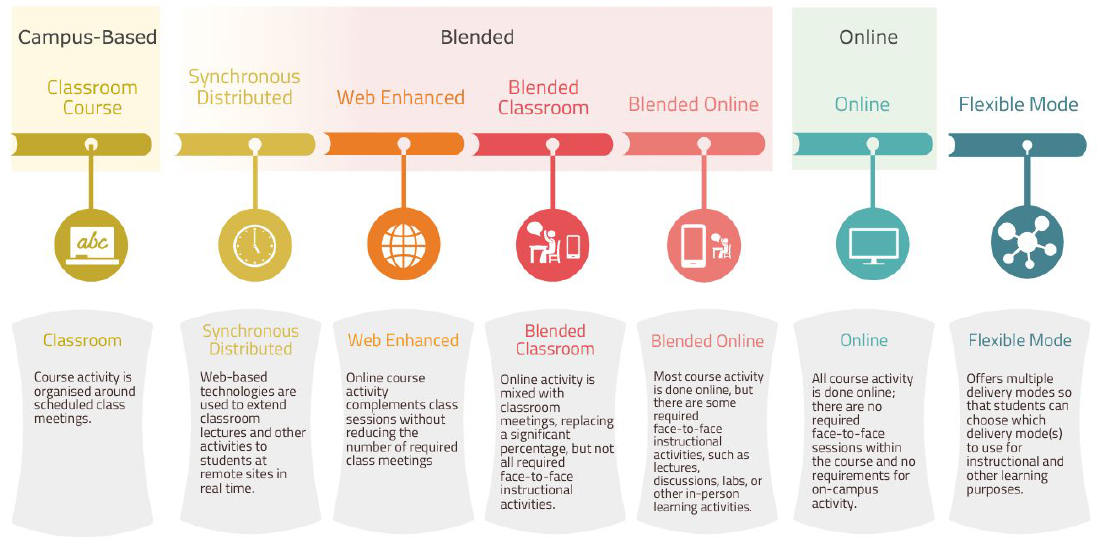
Figure 1: Models of Technology Enhanced Learning According to Sener